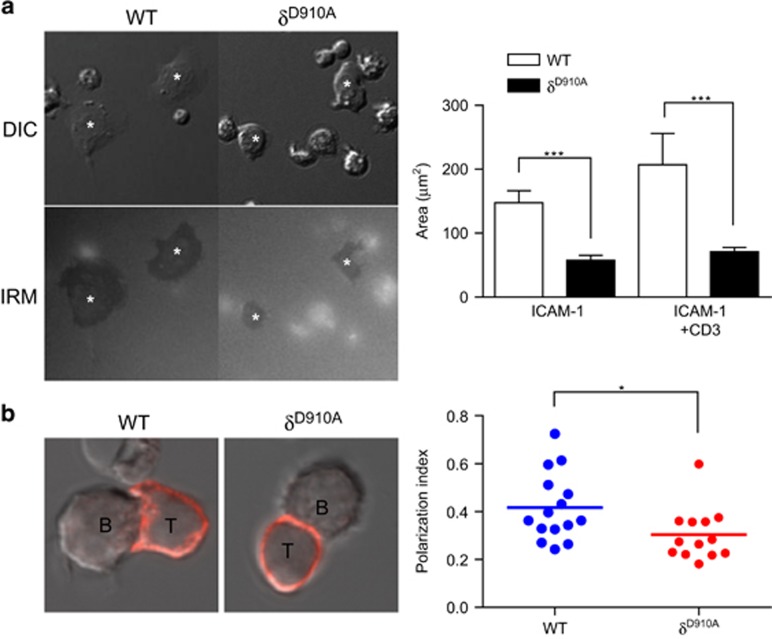
p110δ is required for T-cell spreading on ICAM-1 and APC. (a) WT and p110δD910A CD4+ T-cell blasts were settled on anti-CD3 mAb plus ICAM-1coated coverslip. DIC and IRM images are shown and quantified. Data in the histogram represent the means of two independent experiments. (b) p110δ is required for T-cell spreading on APC. The polarisation index of WT or p110δD910A CD4+ T-cell blasts interacting with OVA323-339-loaded APC was quantified as described in Methods. A round cell would have a value of 0. Representative images of a conjugate formed by WT or p110δD910A T cells (labelled with a PE-anti-CD3 mAb) are shown. Data are representative of three independent experiments.